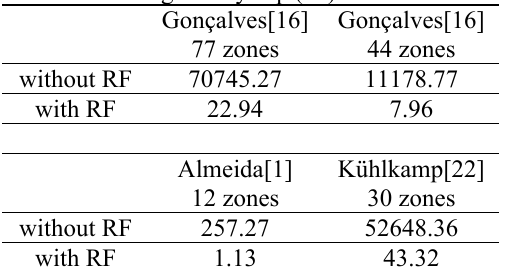
Table 11 – Mean optimal value of the objective function given by Eq. (15).